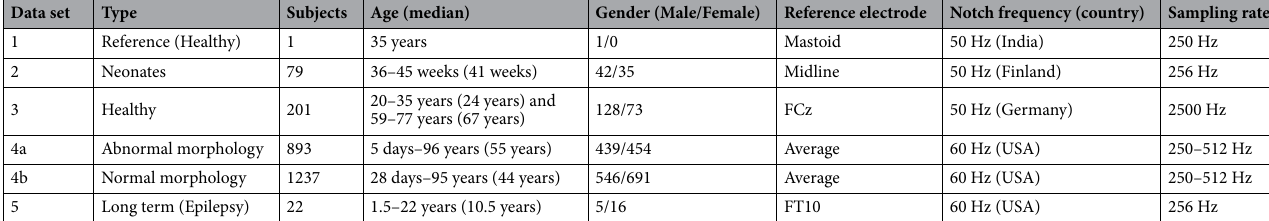
Table 2. Description of data sets used in the study. 54 subjects are common between data sets 4a and